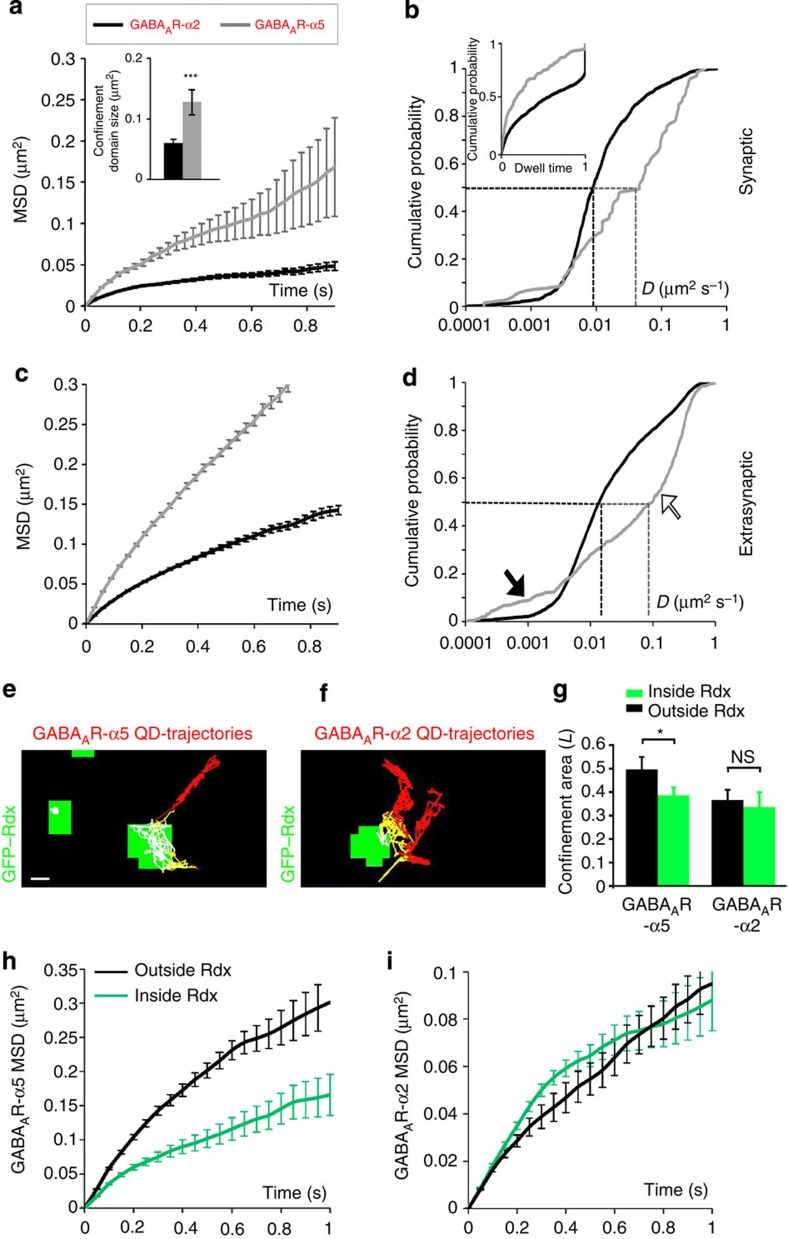
Diffusion properties of GABAAR-α2 and GABAAR-α5 inside and outside of GFP–Rdx clusters.(a) Mean square displacement (MSD) versus time plot for GABAA receptors containing α2 subunits (black) and GABAA receptors containing α5 subunits (grey) quantum dot (QD) trajectories at gephyrin-positive inhibitory synapses. Inset: average size of the confinement domain for GABAAR-α2 (black, 0.059±0.006 μm2) versus GABAAR-α5 (grey, 0.127±0.020 μm2, P<0.001, t-test) at synapses. (b) Cumulative probability plot for GABAAR-α2- and GABAAR-α5-QD diffusion coefficients at gephyrin-positive inhibitory synapses (P<0.001, Kolmogorov-Smirnov (KS) test). Median diffusion coefficients for GABAAR-α2 (0.009 μm2 s−1) and GABAAR-α5 (0.046 μm2 s−1) are indicated by dashed lines. Inset: cumulative probability of dwell time (time at synapses/total time) at synapses (P<0.001, KS test). (c) MSD versus time plot for GABAAR-α2 (black) and GABAAR-α5 (grey) QD trajectories at extrasynaptic sites. (d) Cumulative probability plot of GABAAR-α2 and GABAAR-α5 QD diffusion coefficients at extrasynaptic sites (P<0.001, KS test). Median diffusion coefficients for GABAAR-α2 (0.014 μm2 s−1) and GABAAR-α5 (0.097 μm2 s−1) are indicated by dashed lines. Solid arrow: population of extrasynaptic GABAAR-α5 with a smaller diffusion coefficient than GABAAR-α2. Open arrow: population of extrasynaptic GABAAR-α5 with a greater diffusion coefficient than GABAAR-α2. (e,f) Representative extrasynaptic QD trajectories of (e) GABAAR-α5 and (f) GABAAR-α2 in hippocampal neurons expressing GFP–Rdx (green). Receptor trajectories: outside of Rdx cluster (red), peripheral (yellow), inside clusters (white). (g) Confinement area of GABAAR-α5 and GABAAR-α2 inside (α2: 0.33±0.06; α5: 0.38±0.03) and outside (α2: 0.36±0.04; α5: 0.49±0.05) of Rdx cluster (n=59/78, P<0.05, paired t-test). (h,i) MSD versus time plot for (h) GABAAR-α5- and (i) GABAAR-α2-QD trajectories outside (black) and inside (green) of Rdx-positive cluster at extrasynaptic sites. Scale bars, 500 nm. Error bars, mean±s.e.m. NS, not significant.